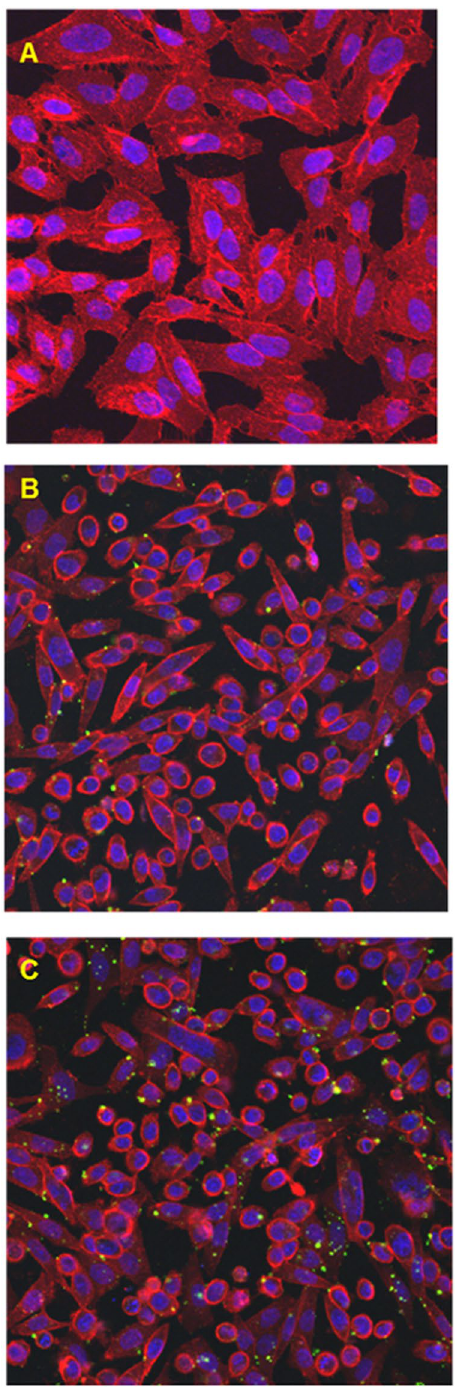
Figure 2. Lead-induced phosphatidylserine translocation in scramblase-transfected CHO cells. Fluorescence imaging of annexin V staining (green) in CHO cells. Annexin V staining was used to detect translocation of phosphatidylserine (PS) from the internal to the external surface of the cell membrane. Control ( A ), 10 nM Pb 2 + ( B ), and 10 μ M Pb 2 + ( C